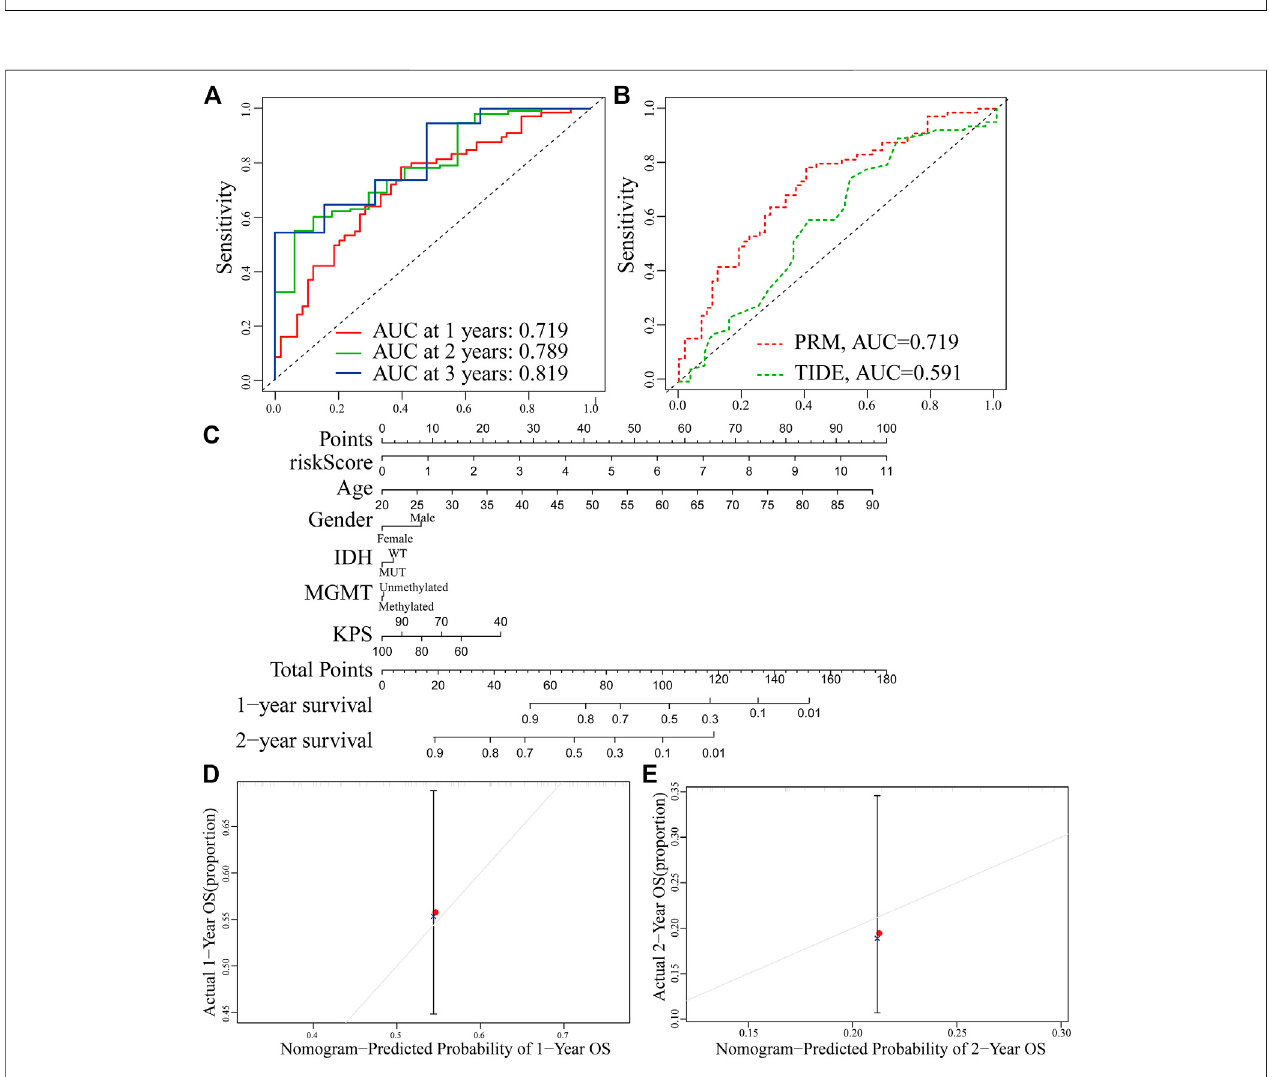
FIGURE 10 | Establishment and veri fi cation of the prognostic risk model. (A) ROC curve of the PRM comprising STAT3, SEMA4F, GREM2, MDK, and SREBF1 expression at 1-year survival, 2-year survival, and 3-year survival. (B) Comparison between the traditional TIDE model and prognostic risk model. (C) Nomogram based on the PRM and clinicopathological factors. Calibration plot evaluating the predictive accuracy of the nomogram at 1-year survival (D) and 2-year survival (E) .